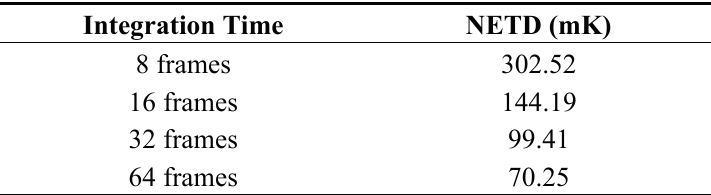
Table 2. NETD behavior of